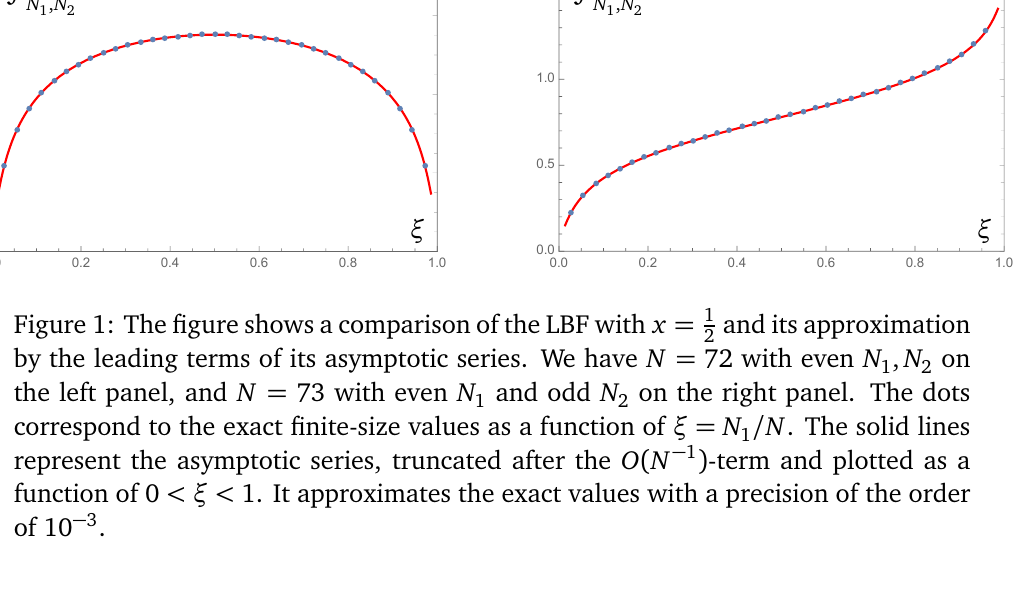
Figure 1: The figure shows a comparison of the LBF with x = 1 by the leading terms of its asymptotic series. We have N = 72 with even N the left panel, and N = 73 with even N correspond to the exact finite-size values as a function of ξ = N represent the asymptotic series, truncated after the O ( N − 1 ) -term and plotted as a function of 0 < ξ < 1. It approximates the exact values with a precision of the order of 10 − 3